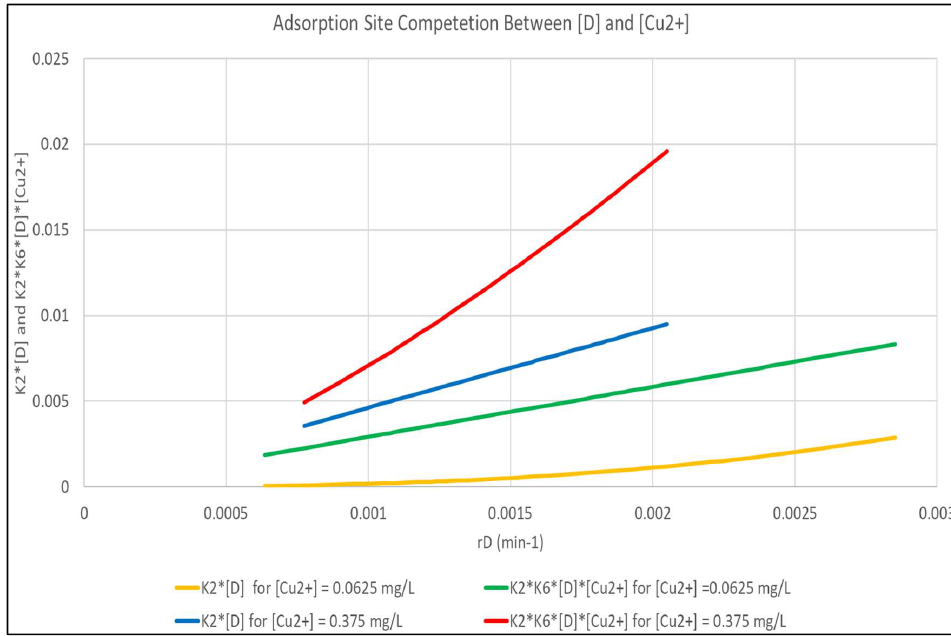
Figure 5. Analysis of the Interaction Term in Equation (7) Between [D] and [Cu 2+ ] Molecules.